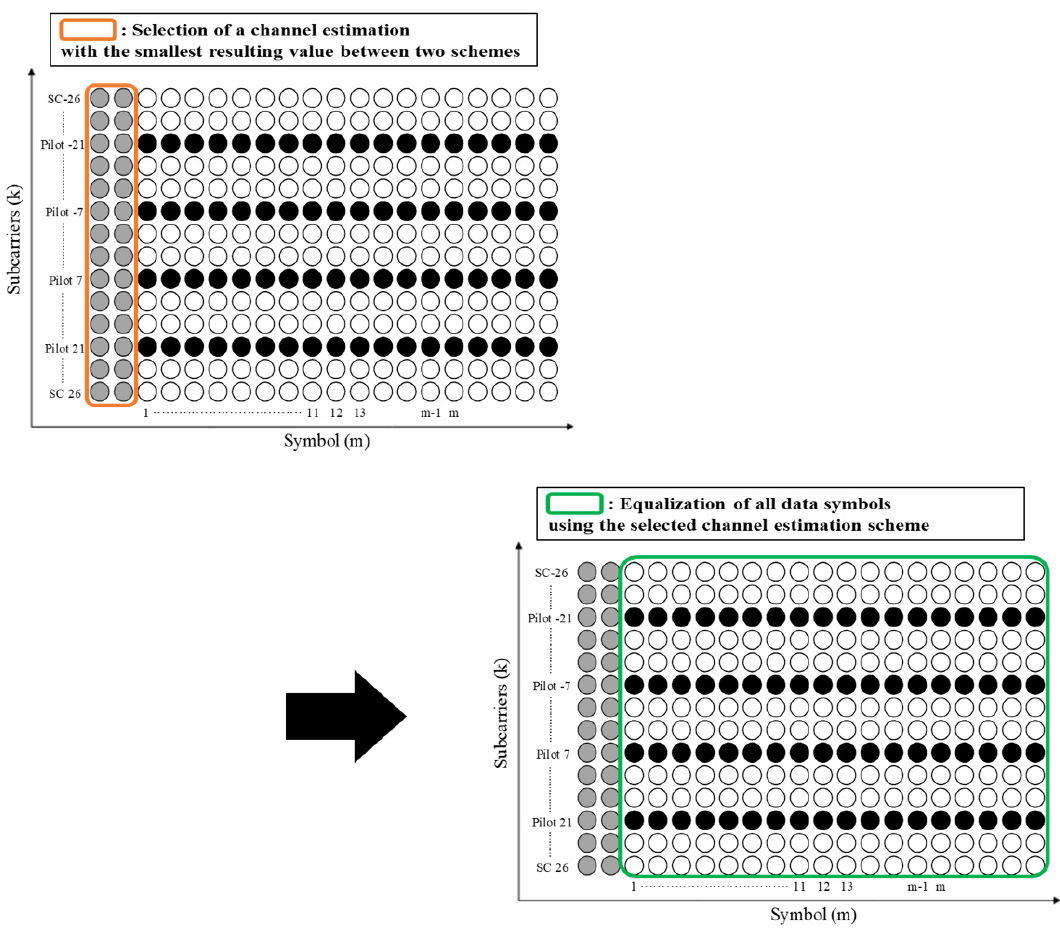
Figure 5. The last step of the proposed